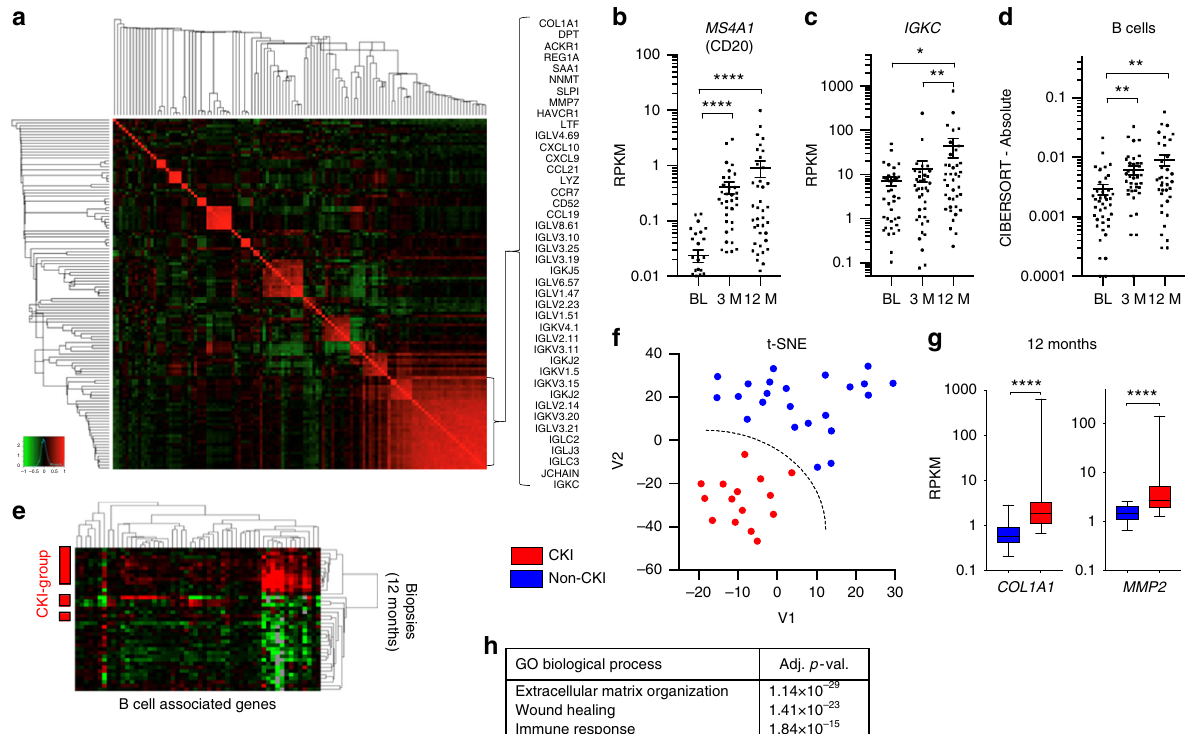
Fig. 1 Chronic kidney injury and B cell immunity in human allografts. a Heatmap showing the gene expression correlation of the 120 most variably expressed genes across kidney biopsies collected at 3 and 12 months after transplantation ( N = 80). The names of the genes included in the cluster in the bottom right corner are shown. b , c RPKM values of MS4A1 (CD20) and IGKC over time in human kidney allograft biopsies. BL: baseline. N = 39 – 42 for each time point. Wilcoxon matched-pairs signed rank test, **** P < 0.0001, ** P < 0.01, * P < 0.05. d Semi-quantitative evaluation of immune cell in fi ltrates in the kidney at different time points after transplantation as determined by CIBERSORT analysis on RNAseq data. N = 39 – 42 for each time point. Wilcoxon matched-pairs signed rank test, ** P < 0.01. e Cluster analysis based on the expression of B cell-associated genes including kidney biopsies collected at 12 months after transplantation ( N = 39). Patients classi fi ed in the CKI group are indicated on the left. f t-SNE analysis on RNAseq data from kidney biopsies collected 12 months after transplantation de fi ning the classi fi cation of patients in the CKI group. The boundary was determined by visual examination of the t-SNE plot. N = 39. g RPKM values of COL1A1 and MMP2 shown as examples of genes differentially expressed in CKI and non-CKI. Mean value and standard error (SE) are shown. Mann – Whitney test, **** P < 0.0001. h Gene enrichment analysis including genes differentially expressed in